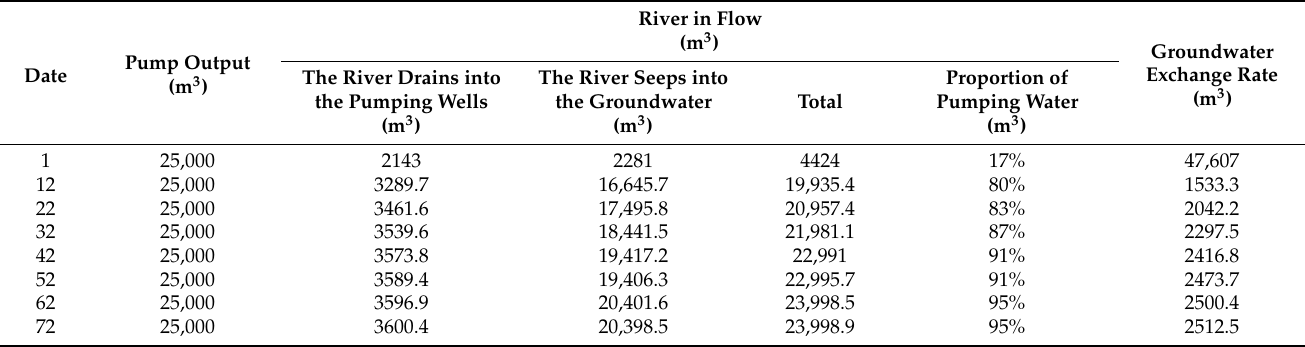
Table 6. Water balance data from a 75% typical dry